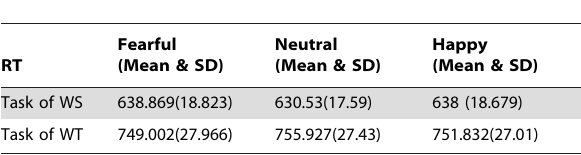
Table 3. Means and standard deviations of the reaction time (ms) in Experiment 2 for the word structure and word tone judgment tasks when fearful, neutral and happy faces were unattended